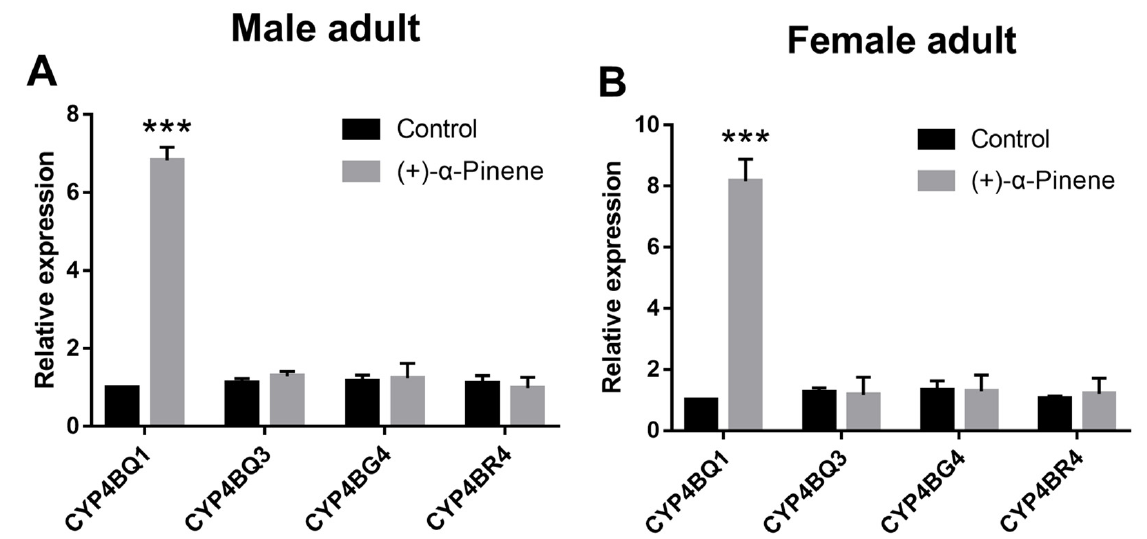
Figure 1. Relative expression levels of four CYP4B genes in D. armandi emerged male ( A ) and female ( B ) adults after stimulation with LC 50 (+)- α -pinene at exposure time of 72 h. The asterisk indicates a significant difference between different treatment groups (*** p < 0.001, independent Student’s t -test). All values are the mean ± SE, n = 3.